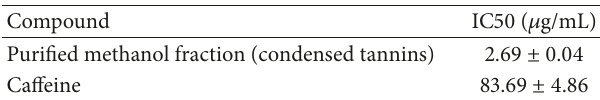
Table 5: Evaluation assay for antioxidant activity of two compounds from tea mangrove